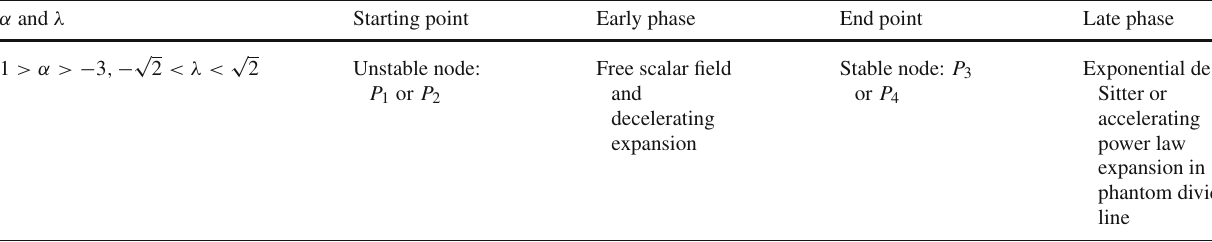
Table 9 Different phase-generic evolution -decelerating to accelerating evolution α and